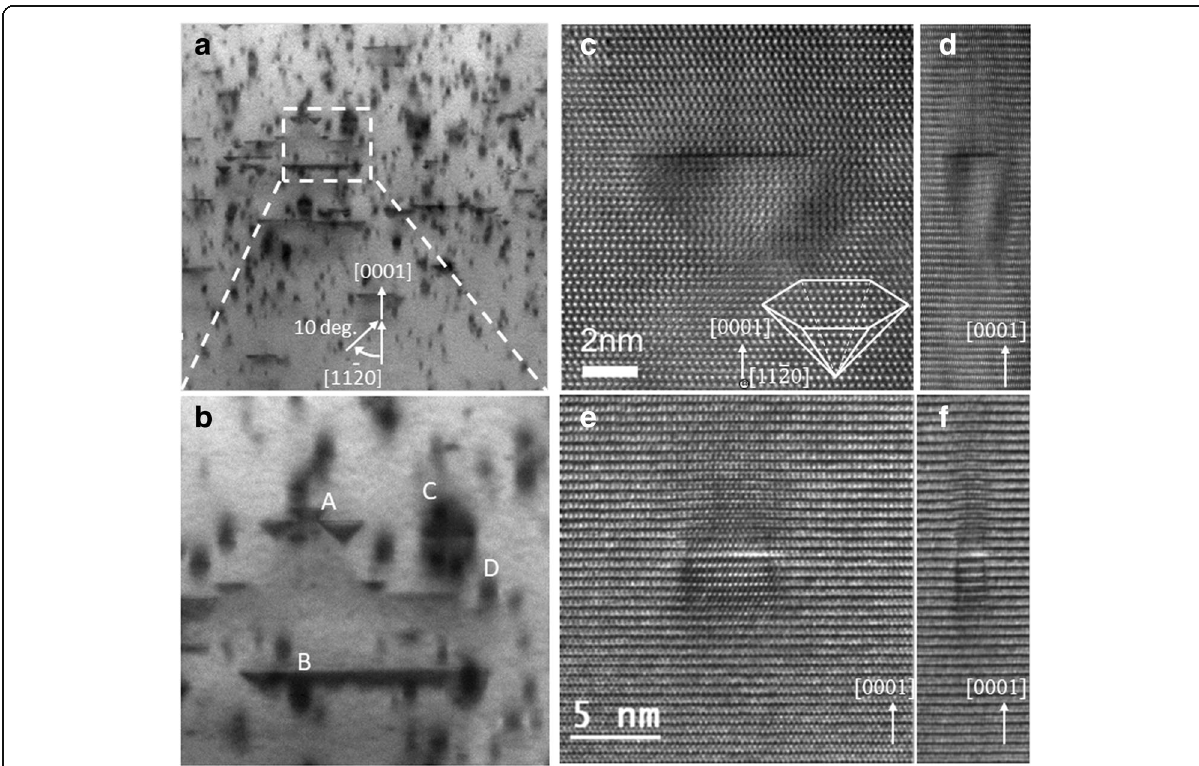
Fig. 2 a Cross sectional bright field STEM image of Mg implanted GaN sample obtained in off-zone axis condition to strengthen the defects contrasts. Magnified view of marked region in ( a ) is presented in ( b ) where four different kind of defects labelled as A, B, C and D are observed. High-resolution TEM image of the pyramidal domains labelled as A in ( b ) is shown in ( c ) with schematic representation at right bottom. The distorted lattice on the pyramidal domain are representing by squeezing ( c ) as shown in ( d ). High-resolution TEM image of one typical C or D type defects is presented in ( e ) with squeezed image in ( f ), showing strain field contrast around the